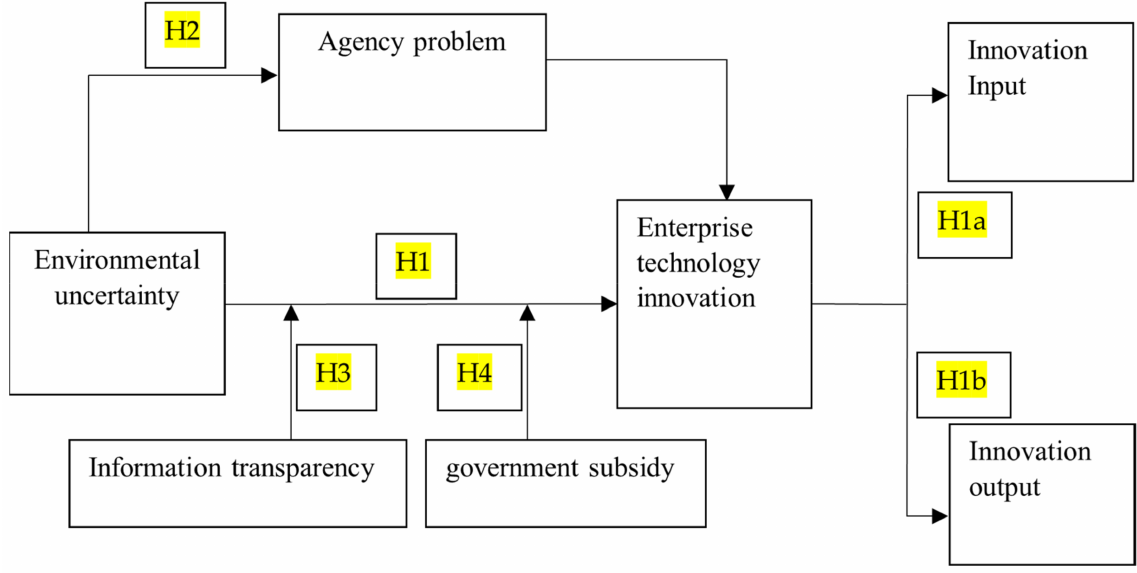
Figure 1. Research idea